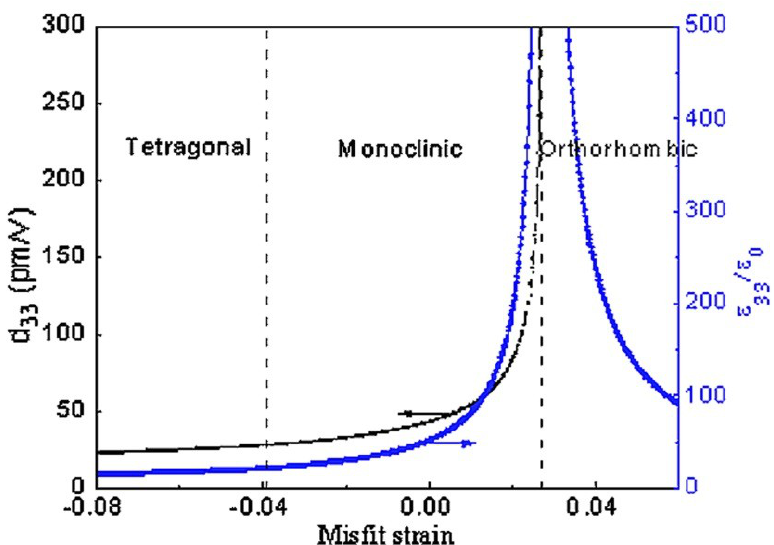
Figure 3. Misfit strain induced phase transition and associated dielectric/piezoelectric responses of BFO films. (Reprinted with permission from [28]. Copyright 2010